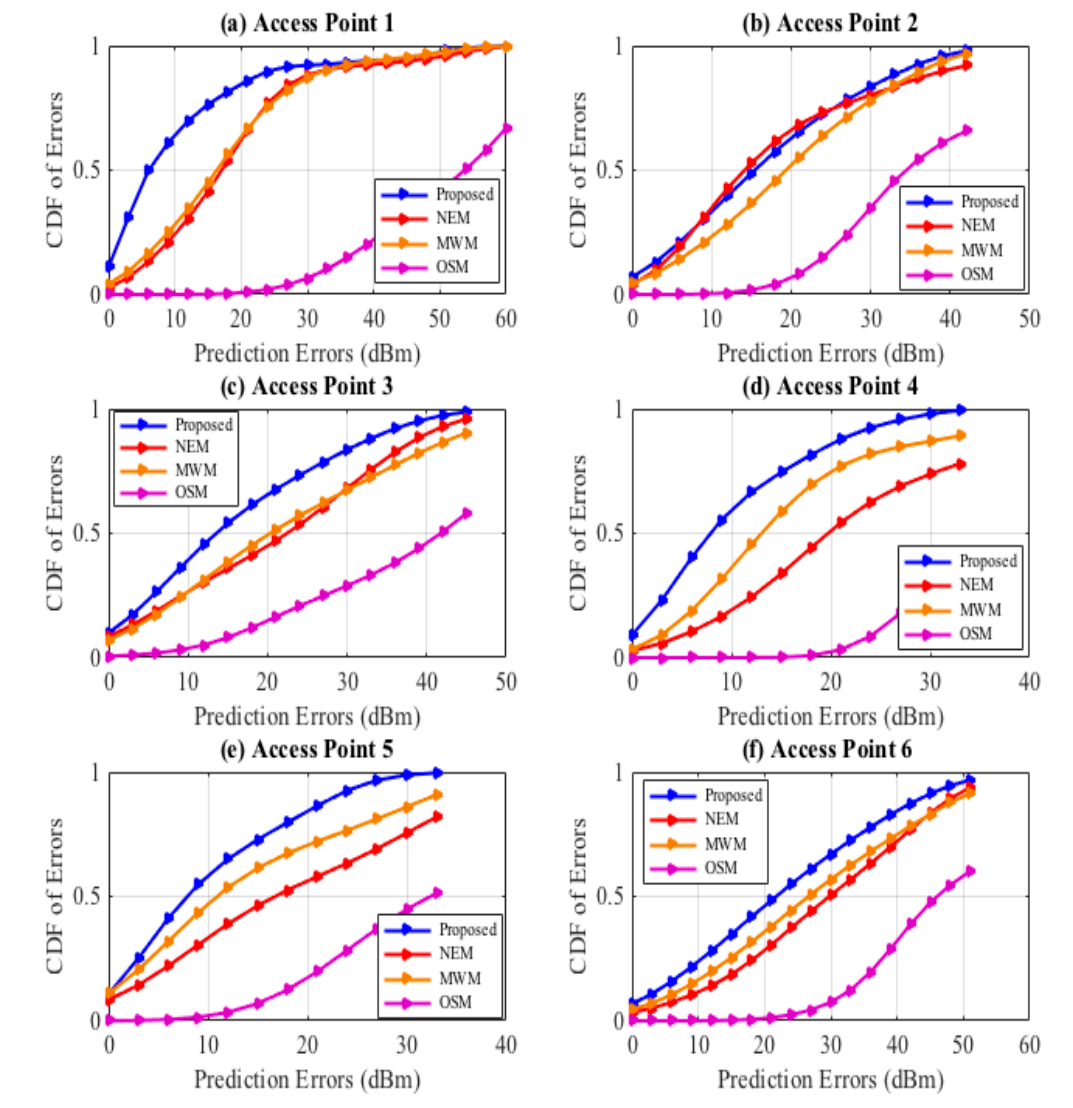
Figure 5. CDF Prediction Errors, AP1, AP2, AP3, AP4.